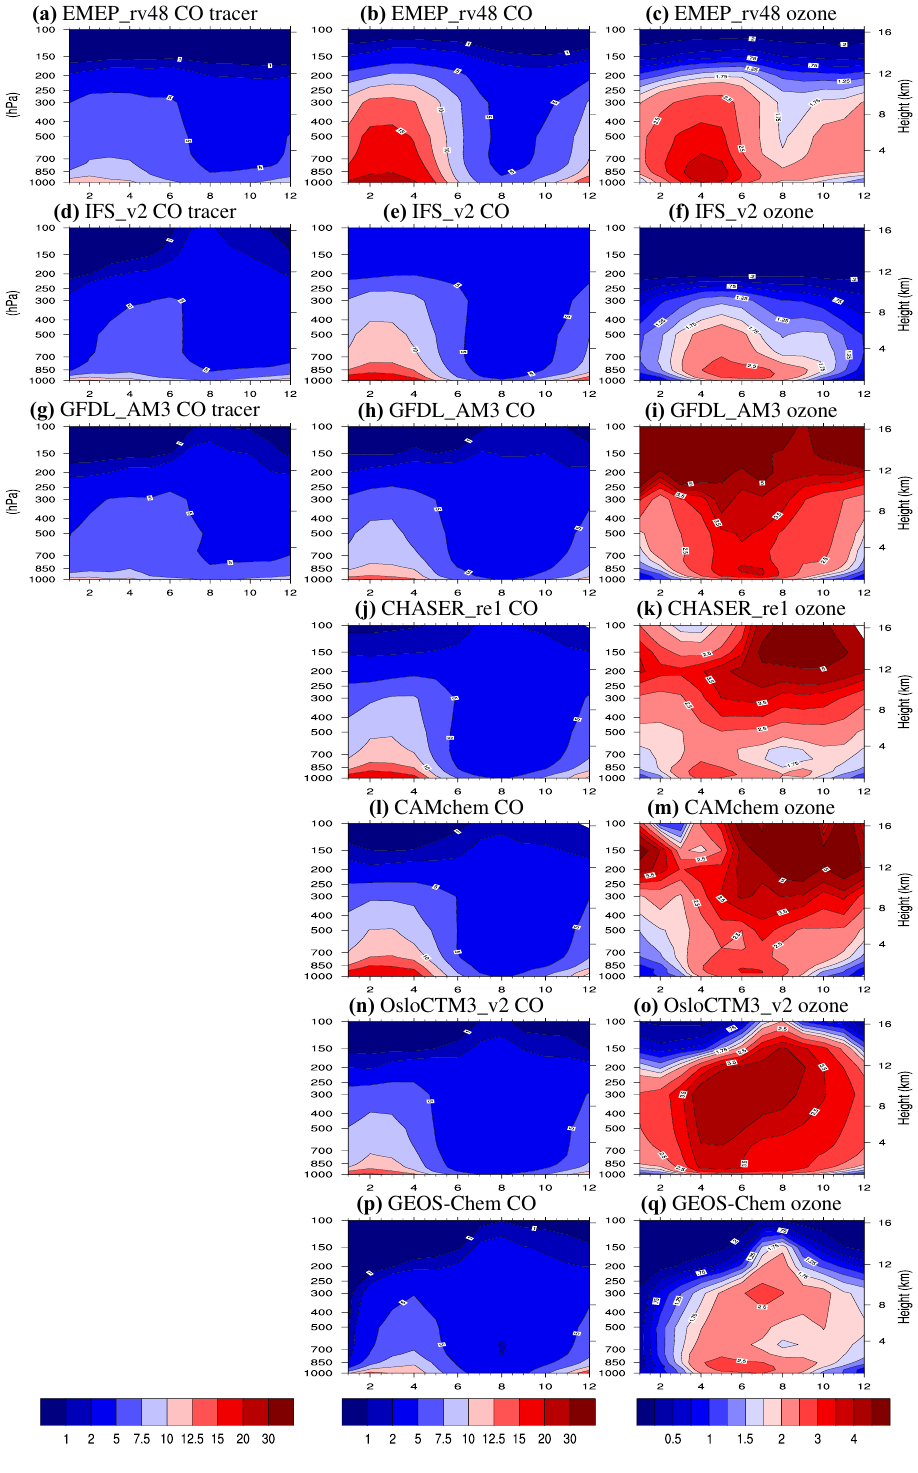
Figure 4. Monthly contributions from the 20% (BASE–GLOALL) perturbations of the anthropogenic emissions to co50 tracer (a, d, g) , CO (b, e, h) and O 3 (c, e, f) in ppb averaged for the area bounded by 10 ◦ W to 35 ◦ E and 30 to 60 ◦ N. The models have been interpolated to a common vertical